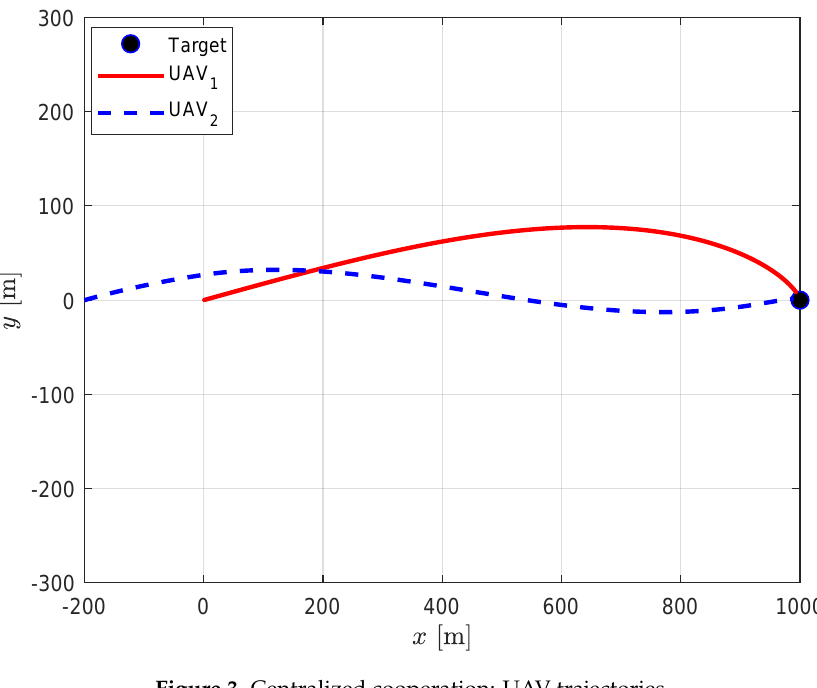
Figure 3. Centralized cooperation: UAV trajectories. Table 2. Results from the centralized cooperation with full